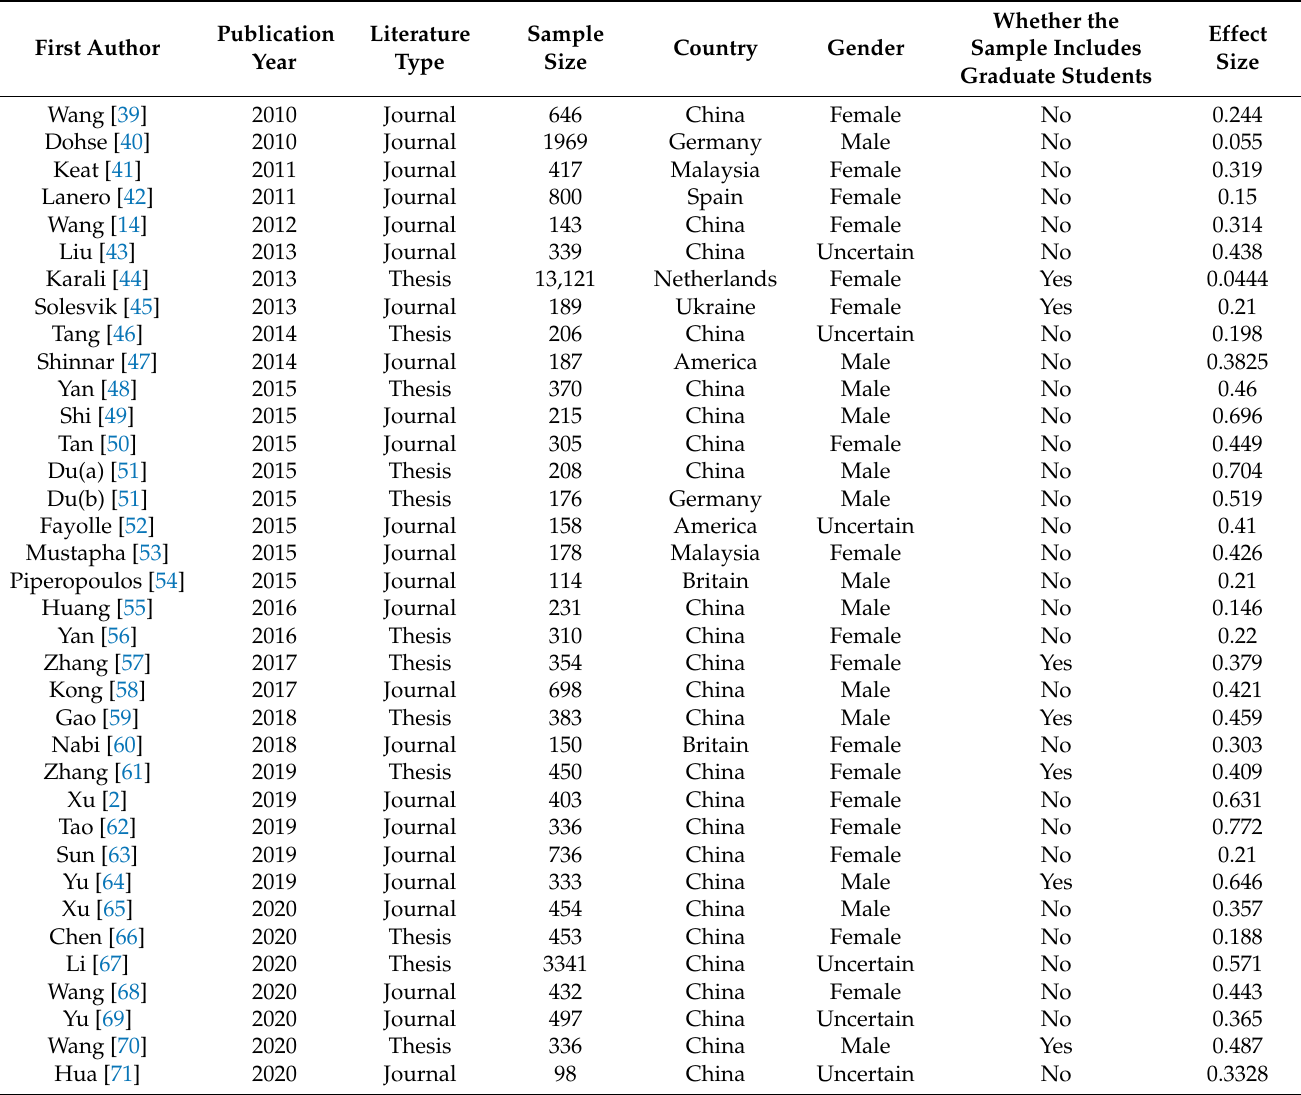
Table 1. Meta-analysis literature